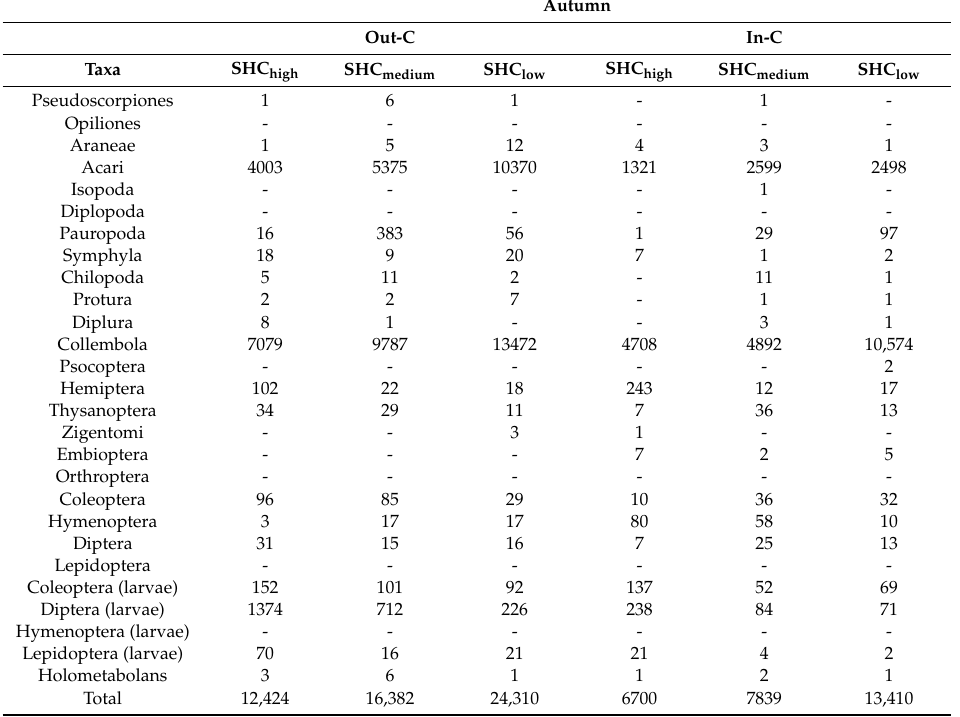
Table A7. Absolute numbers of microarthropods found at each SHC (high, medium and low livestock pressure), in each Location (beneath tree canopy = In-C or outside the canopy = Out-C) during the second sampling